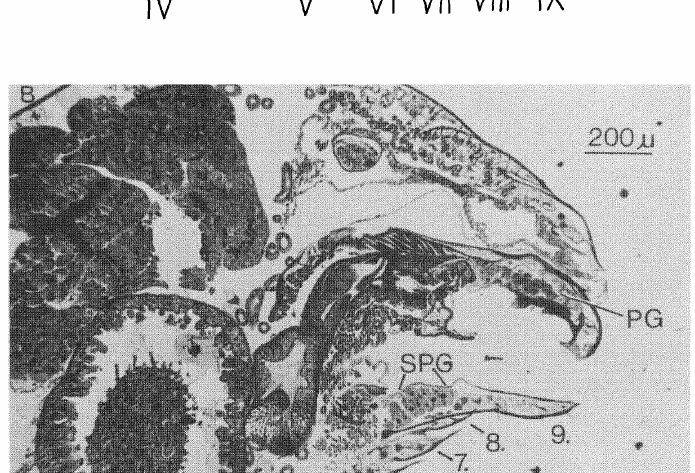
. . A. Schematic drawing of a longitudinal section through the gaster of a B. Longitudinal section through 6th, 7th, 8th and 9th abdominal Novomessor A=anus; P=part of penis with penis segments of a Novomessor aibisetosus gland; PG=pygidial gland; PPG=post-pygidial gland; SPG=subgenital plate